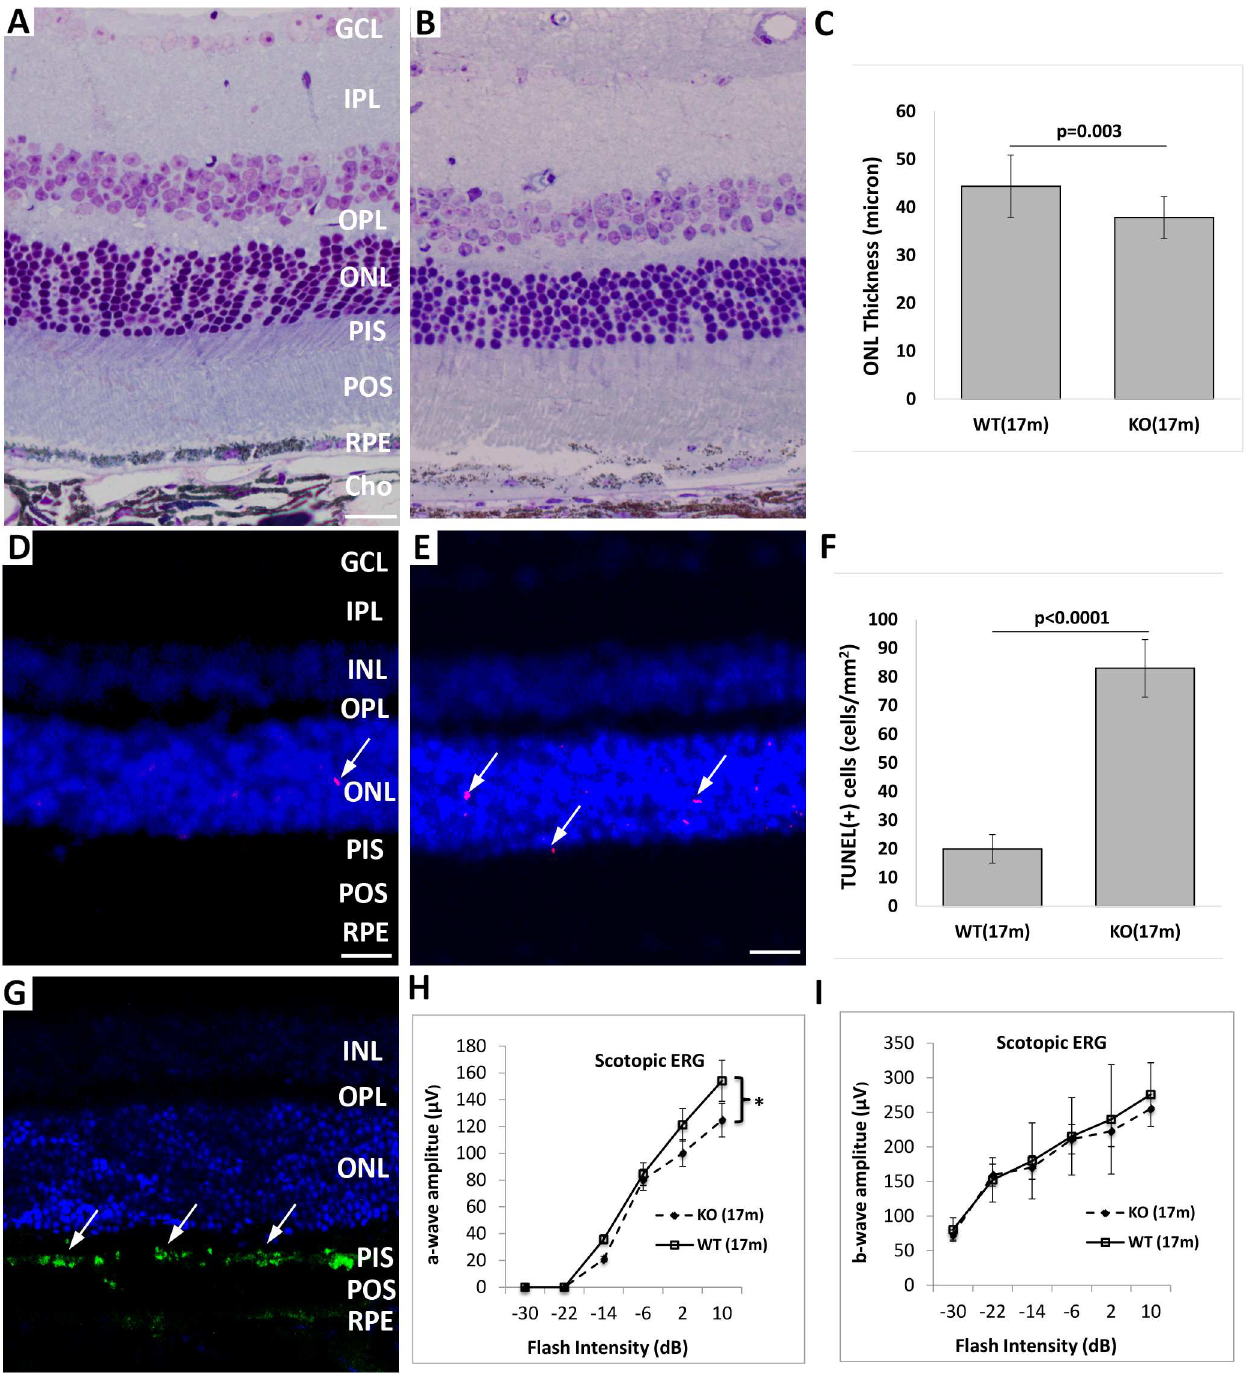
Fig 7. Photoreceptor degeneration in aged Cxcr5 -/- mice. 17-month-old C57BL/6WT mice and Cxcr5 KO mice were used. ( A and B ) Representative toludinblue-stainedimages of the WT mice ( A ) and the KO mice ( B ). ( C ) Quantification of ONL thickness. The superior retinal areas that were near optical nerve headapproximately 100 micron were used for ONL thickness measurement. The values were the mean ( ± SD; n = 10). ( D and E ) Representative TUNEL staining images of the WT mice ( C ) and the KO mice ( D ). Arrows indicatedthe TUNEL (+) cells in ONL layer. ( F ) Quantification of TUNEL (+) cells (mean ± SD; n = 6). ( G ) Representative active Caspase-3stainingimages of the KO mice. The merged picture with DAPI staining showedthe localizationof the active caspase-3in photoreceptorinner segments. Arrows indicatedactive Caspase-3stainingsignals. ( H and I ) A-wave (H) and b-wave (I) amplitudes of scotopic ERG. The values were the mean ( ± SD; n = 10). * denotedp < 0.05. GCL: ganglioncell layer; IPL: Inner plexiform layer; INL: inner nuclearlayer; OPL: outer plexiformlayer; ONL: outer nuclear layer; PIS: photoreceptor inner segment; POS: photoreceptorouter segment; RPE: retinal pigmentepithelium. doi:10.1371/journal.pone.0173716.g007 PLOS ONE | DOI:10.1371/journal.pone.0173716 March 10,